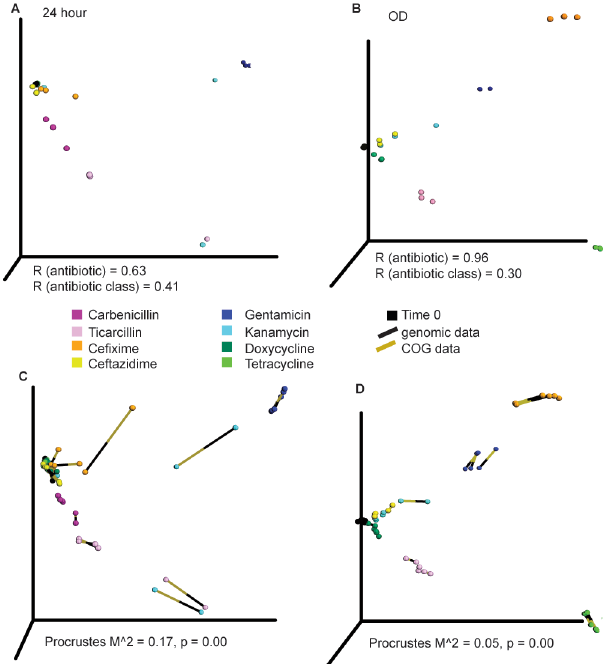
Fig 2. Separation of antibiotic classes in PCoA space is weak across multiple levels of functional hierarchy. (a,b) PCoA analysis, using Bray-Curtis distance, of the antibiotics at (a) 24 hours (b) upon reaching the late exponential phase (OD). ANOSIM R-values are plotted for separation by antibiotic or by mechanism of action. (c,d) Procrustes analysis indicates significant alignment between the COG (gold end of the line) and gene (black end of the line) PCoA profiles in the 24 h and OD selections. The longer the line connecting the COG and gene points, the less aligned the two points are in PCoA space, increasing the stress value (M 2 ).